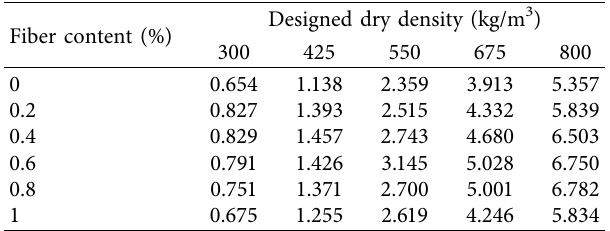
Table 7: Unconfined compressive strength results of polypropylene fiber cast-in-situ foamed concrete (unit: MPa).